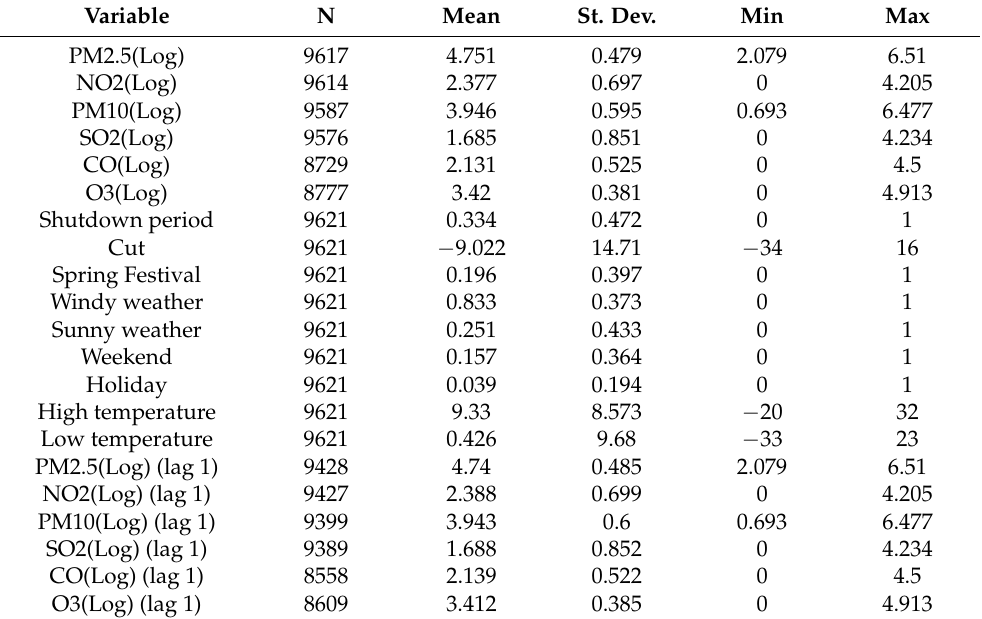
Table 1. Variables